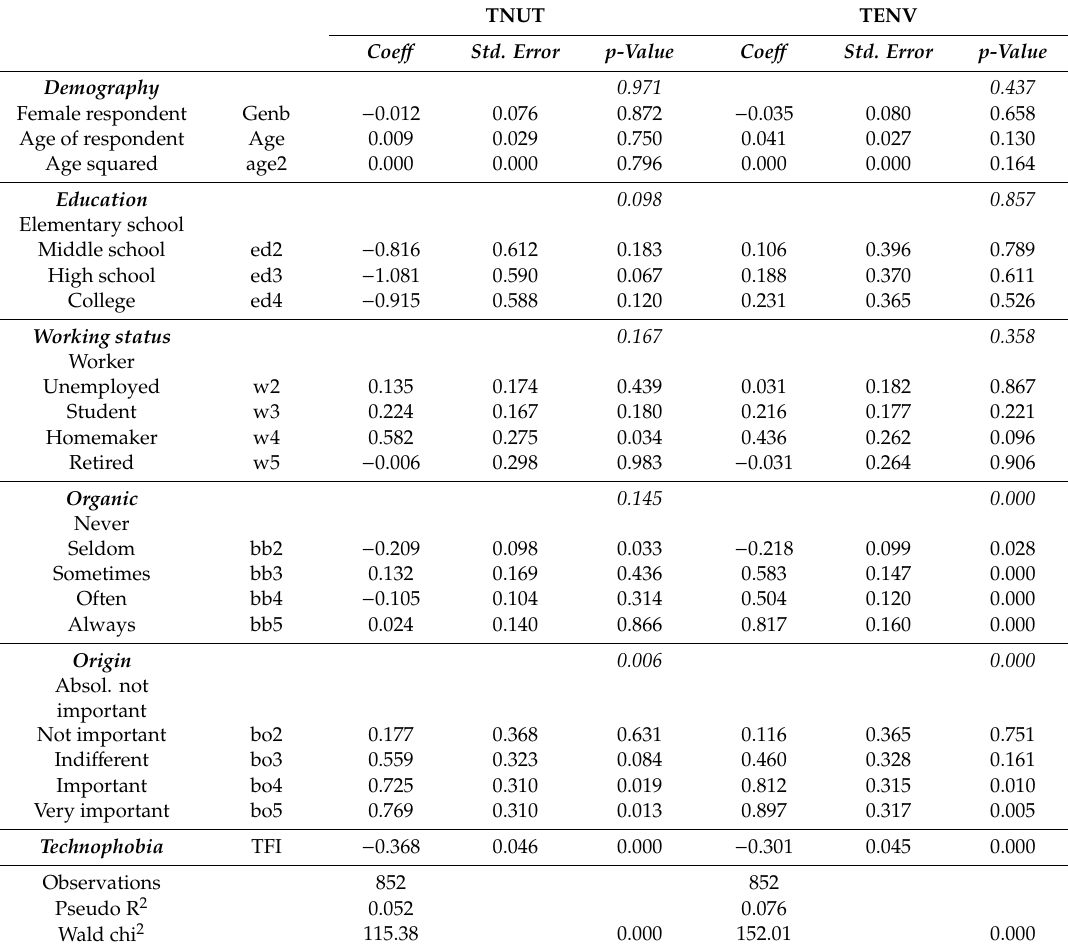
Table 5. Regression